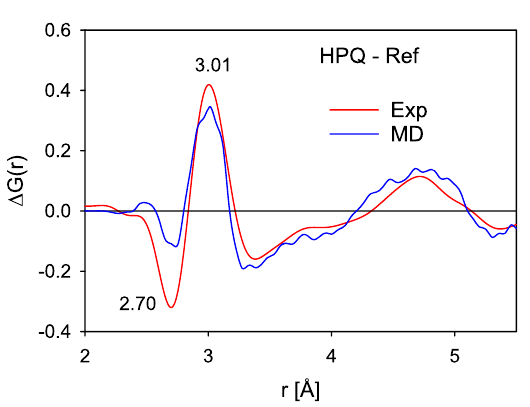
Figure 7. The difference in G ( r ) compared to the as cast sample, Δ G ( r ), for the experimental HPQ sample and the HPQ obtained by MD